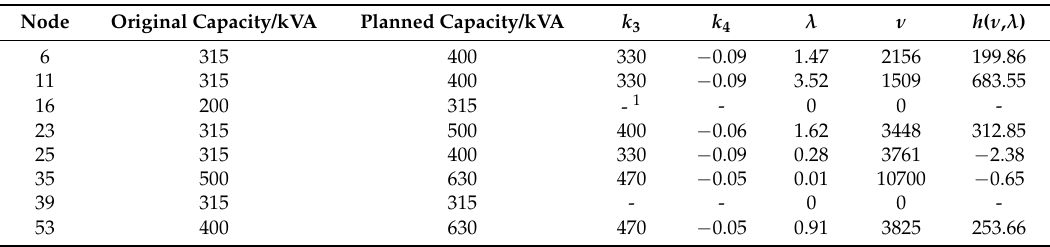
Table 5. Characteristic indexes of annual continuous apparent power curves at 8 electric energy replacement